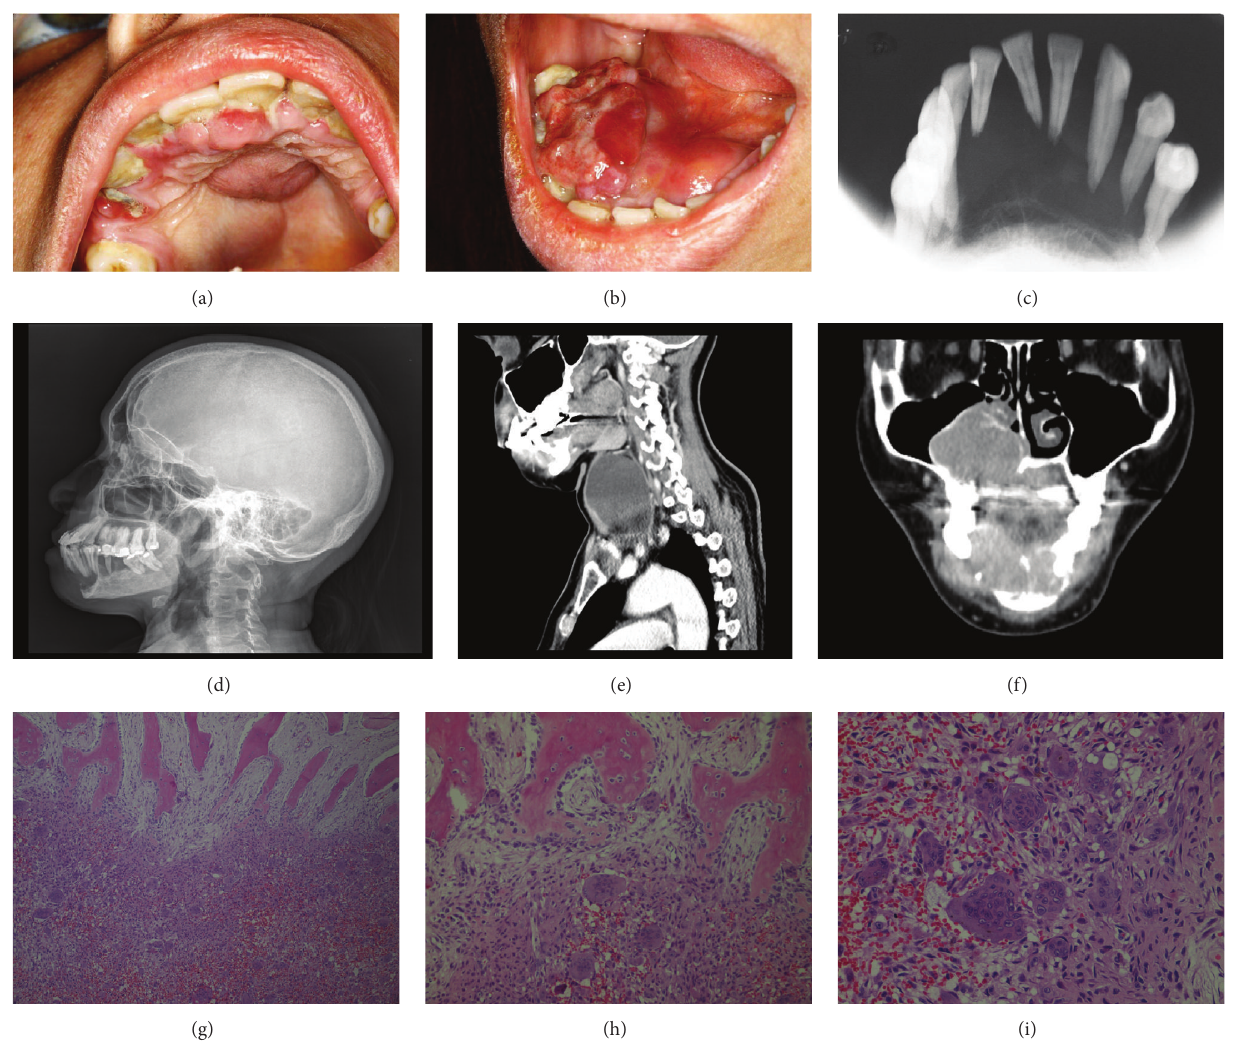
Figure 1: (a)-(b) Clinical aspects of the maxilla and mandible lesions: haemorrhagic tumour masses involving the vestibular and